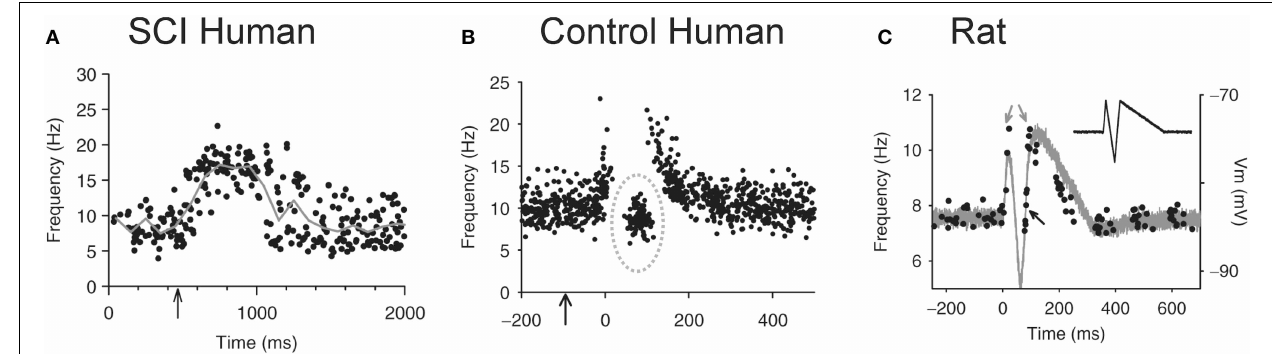
FIGURE 8 | Peristimulus frequencygrams (PSF) in SCI and uninjured participants and in rat. (A) PSF of TA motor units recorded in incomplete SCI participant (AIS C) in response to stimulation of the medial arch of the foot (time marked by arrow, 0.2ms pulse width, 3 pulses, 300Hz, ∼ 50mA) while participant maintained tonic dorsiflexion. Mean rate indicated by solid gray line. (B) PSF recorded from uninjured control participant in response to same medial arch stimulation. Note